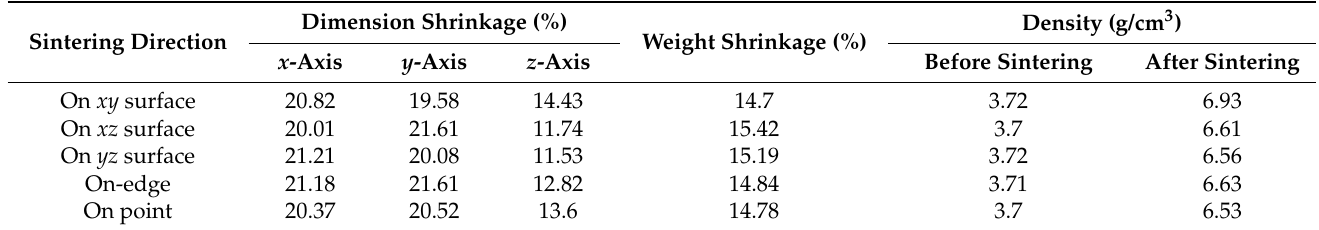
Table 4. Shrinkage for dimension and weight and density of sintered metal cubes in five sintering